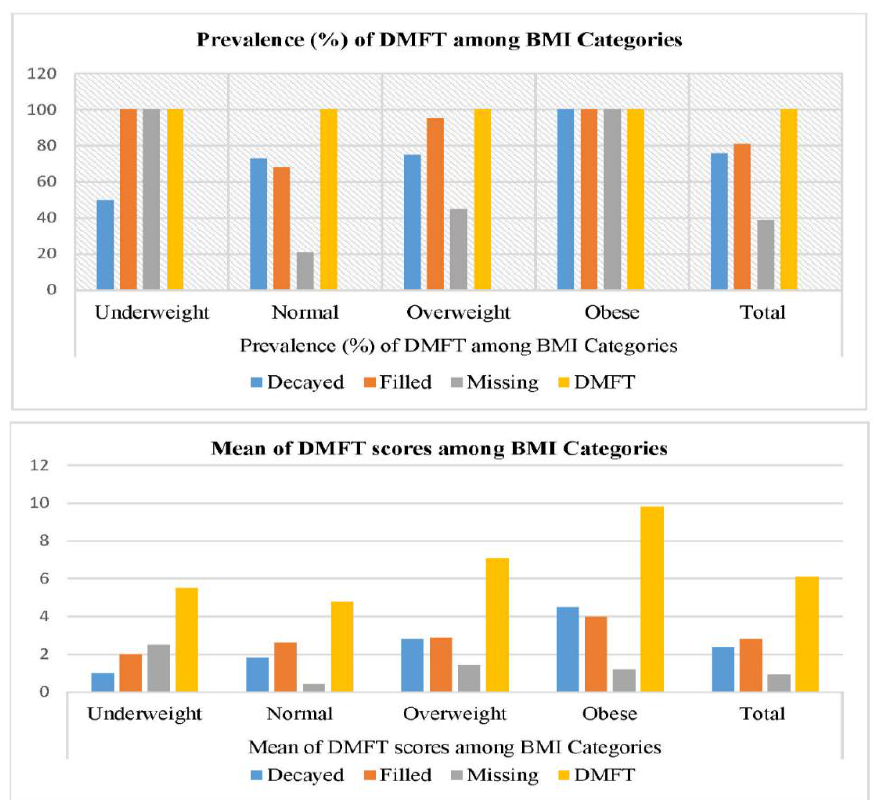
Figure 2. Status of DMFT and BMI categories among study participants.